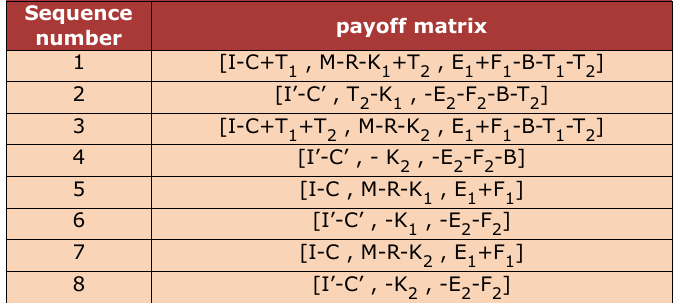
Table 3. Payoff matrix of